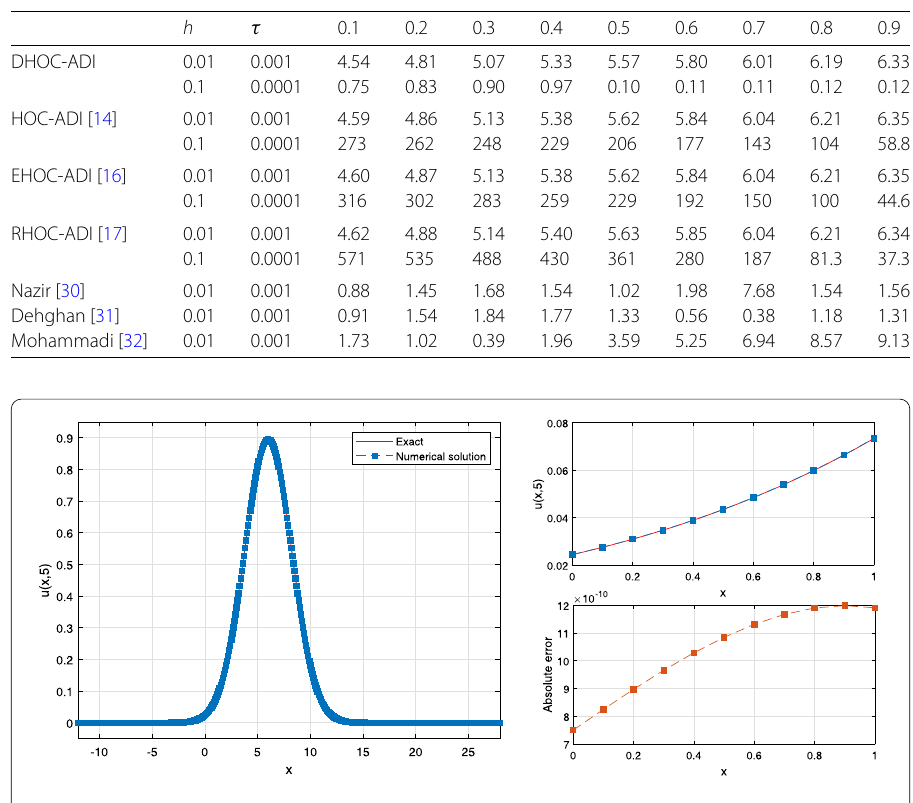
Table 3 Absolute errors ( × 10 –9 ) at different locations at t = 5 for Example 1